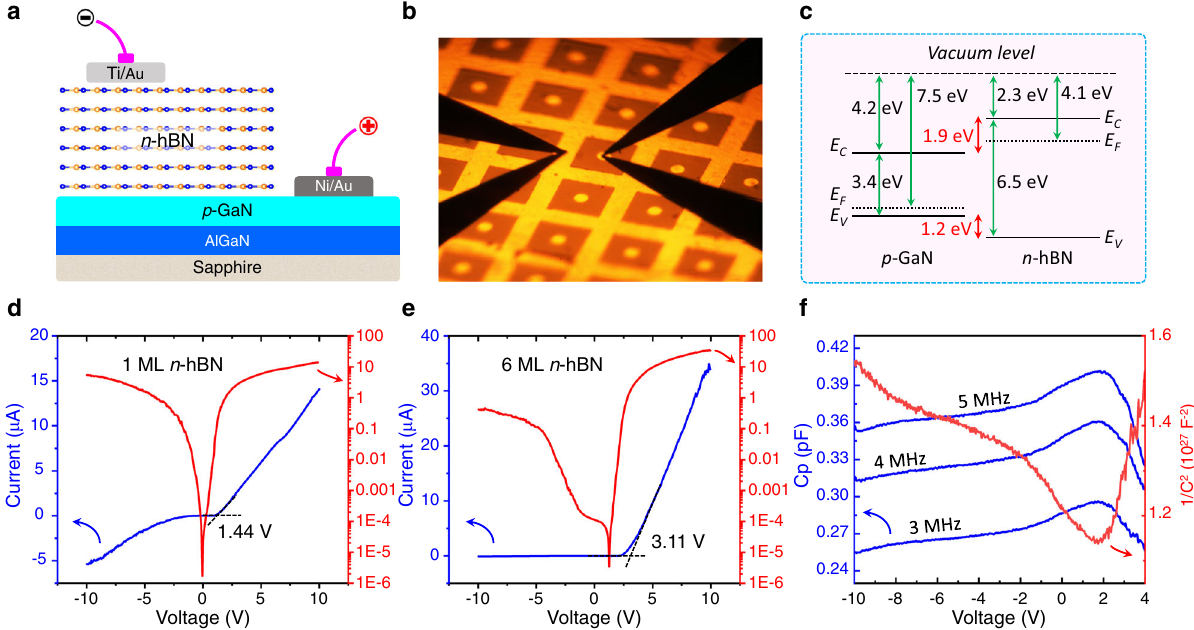
Fig. 5 Vertically stacking heterojunction based on the n -hBN/ p -GaN. a Schematic of the p - n junction based on n -type h-BN and p -type GaN. b Photograph of the fabricated n -hBN/ p -GaN junction array on board. c Band diagram of the n -hBN/ p -GaN junction. d – e Linear and logarithmic I-V curves of the p - n junction based on one monolayer and six monolayers n -type h-BN, respectively. f C-V characteristics measured from reverse to forward bias of the 6-monolayer n -hBN/ p -GaN junction under various ac frequencies and corresponding 1/C 2 plot versus voltage under a frequency of 3